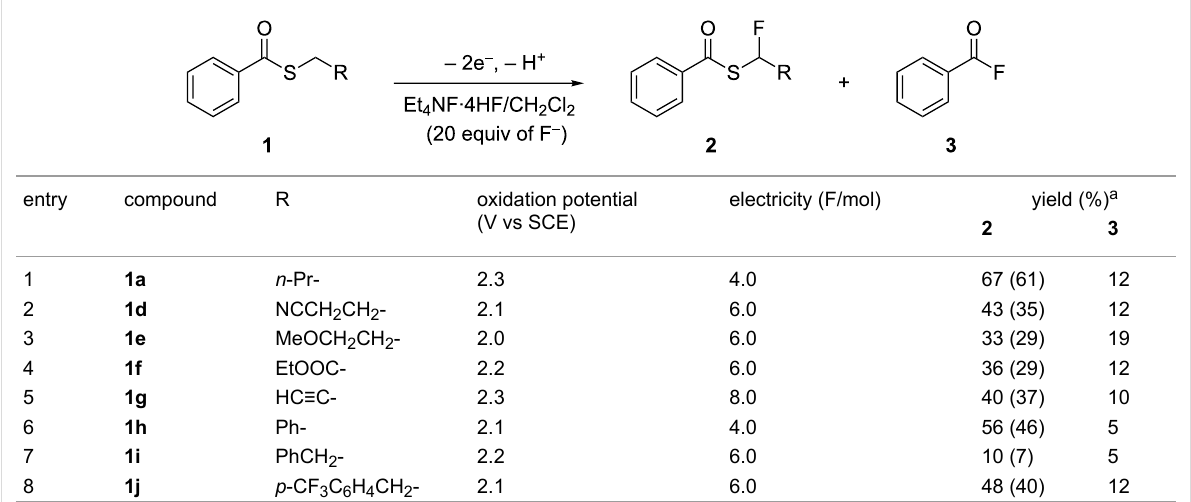
Table 2: Oxidation potentials and electrochemical fluorination of S -substituted alkyl benzothioates.